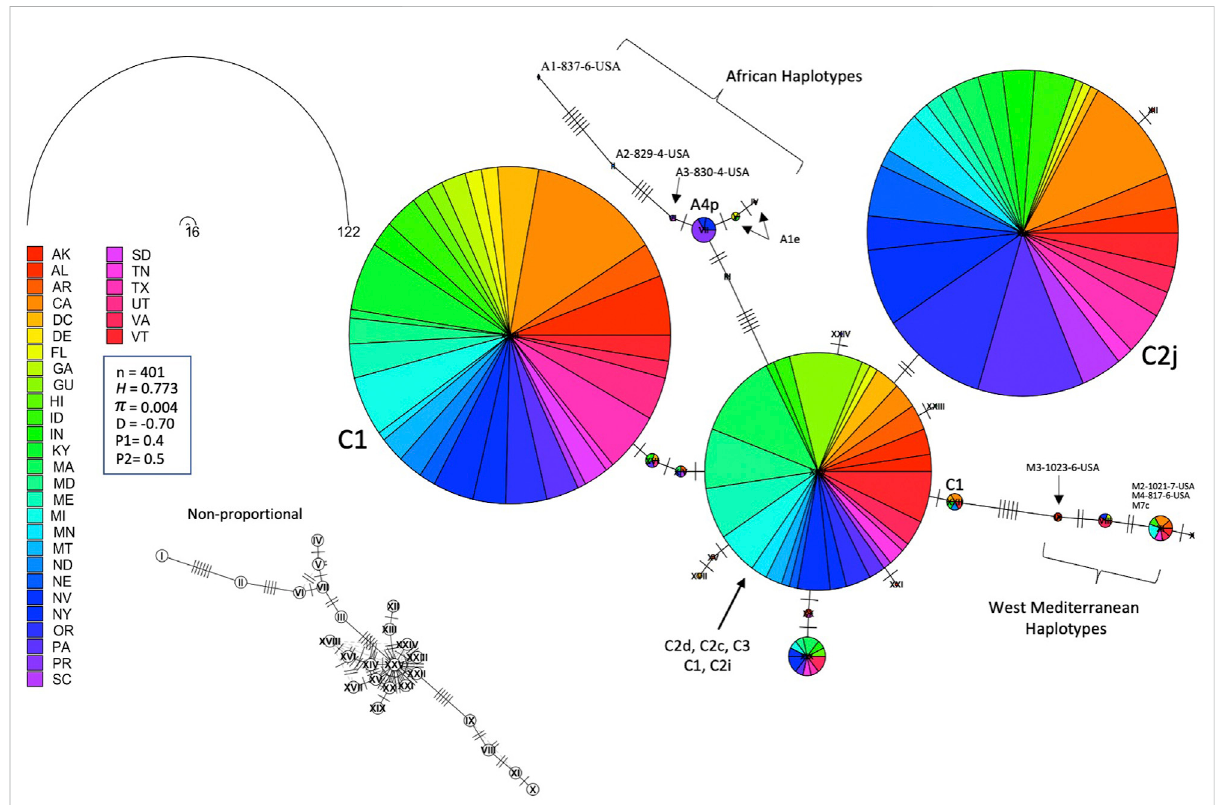
FIGURE 8 Haplotype network of the ND2 gene for samples of all COI-COII lineages displayed by states. Number of samples (n), haplotype diversity ( H ), nucleotidediversity( π ),Tajima ’ sstatistic( D ),Tajima ’ s p -valuesundernormal(P 1 )andbeta(P 2 )distributions.Circlesizeisrelativetothenumberofhaplotype copies present in the dataset. Nucleic changes are represented by perpendicular lines on branches. Non-proportional sub fi gure shows the haplotype secondary network (dotted line) without haplotype copy representation. Central ND2 haplotype is an admixture of multiple COI-COII